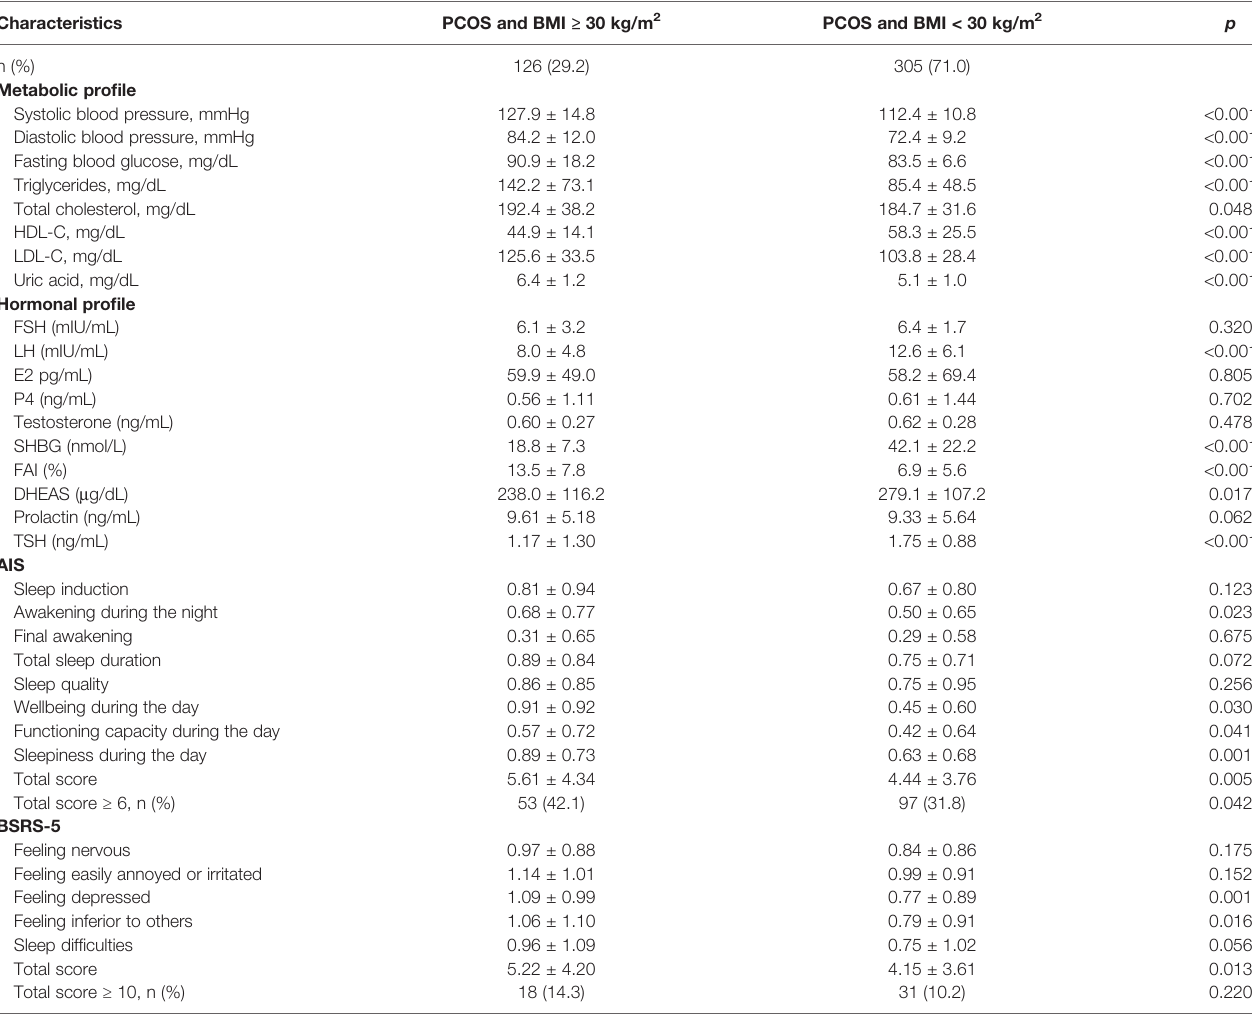
TABLE 4 | Laboratory, sleep, and psychological characteristics of patients with PCOS strati fi ed according to BMI. Characteristics